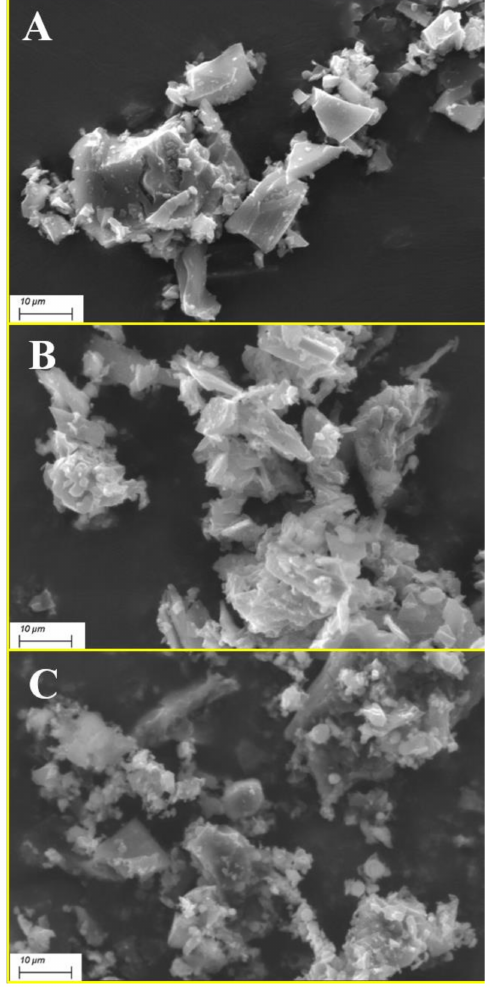
Figure 1. SEM images at 3000 × magnification of biochar (BC) low ( A ), BC medium ( B ), and BC high ( C